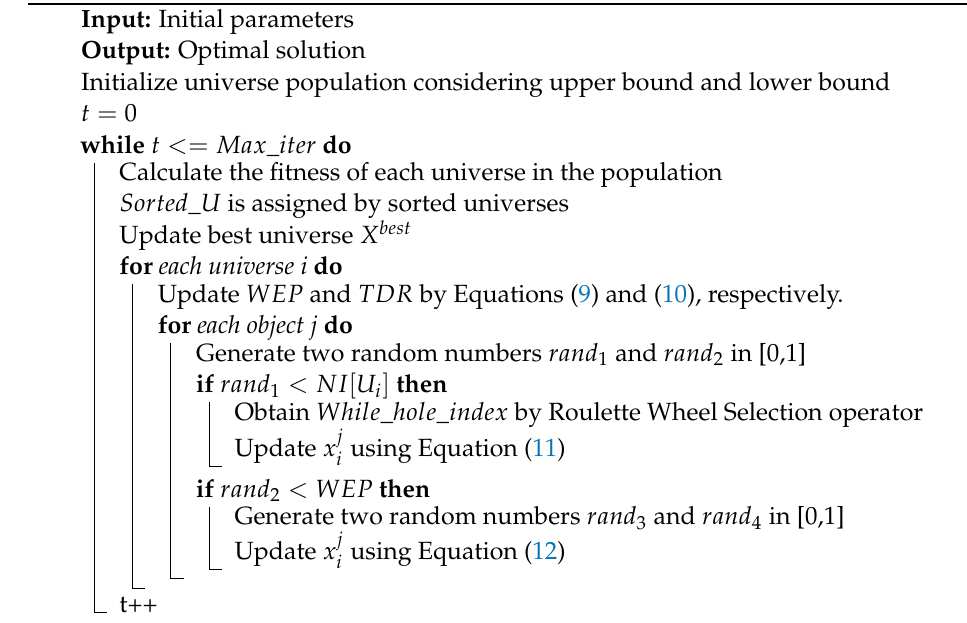
Algorithm 1: The pseudo-code of the MVO algorithm